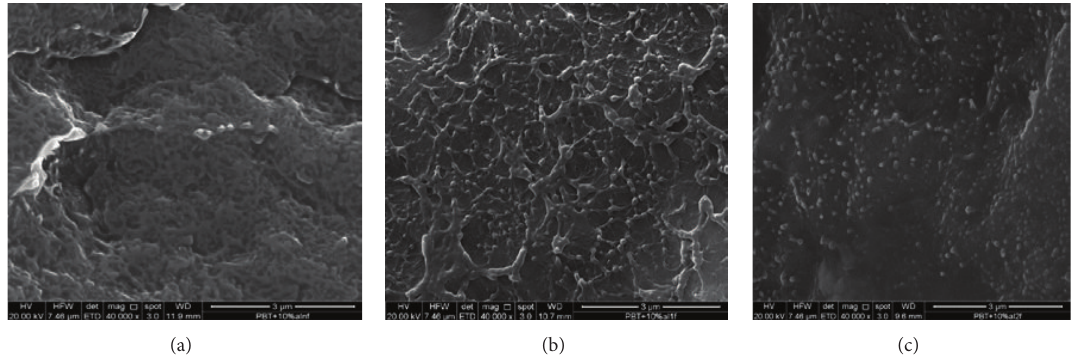
Figure 3: SEM micrographs of fracture surfaces of samples containing 10% by weight of alumina whiskers as received (a), functionalized with GPS (b), and functionalized with MPS